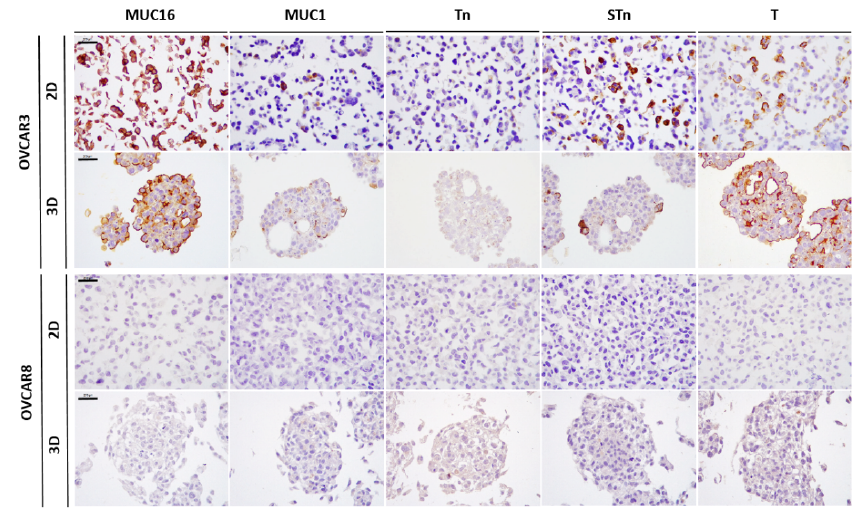
Figure 2. Expression of MUC16, MUC1, Tn, STn, and T in OVCAR3 and OVCAR8 cell lines, cultured in 2D and 3D conditions, assessed by immunocytochemistry. Scale bar, 200 μ m.